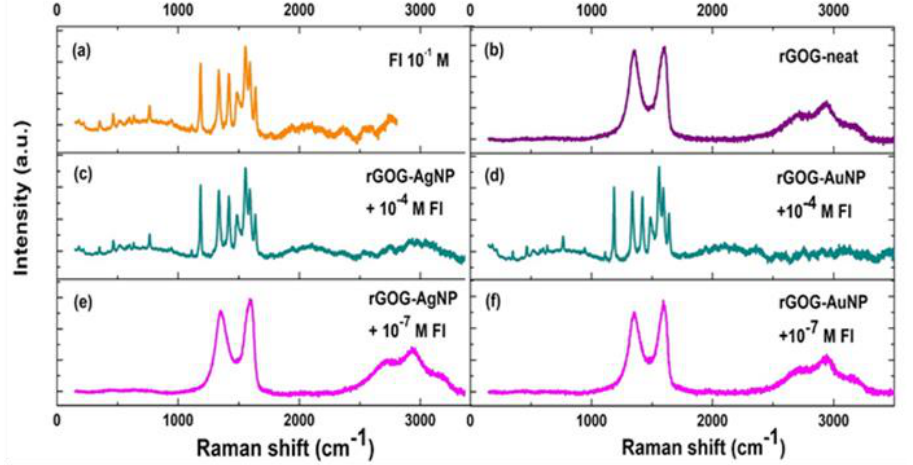
Figure 4. Raman spectra of Fl deposited in different concentration over the respective film: ( a ) Fl deposited from 10 −1 M solution over a glass substrate; ( b ) neat rGOG film; ( c ) Fl deposited from 10 −4 M solution over a rGOG-AgNP film; ( d ) Fl deposited from 10 −4 M solution over a rGOG-AuNP film; ( e ) Fl deposited from 10 −7 M solution over a rGOG-AgNP film; ( f ) Fl deposited from 10 −7 M solution over a rGOG-AuNP film.